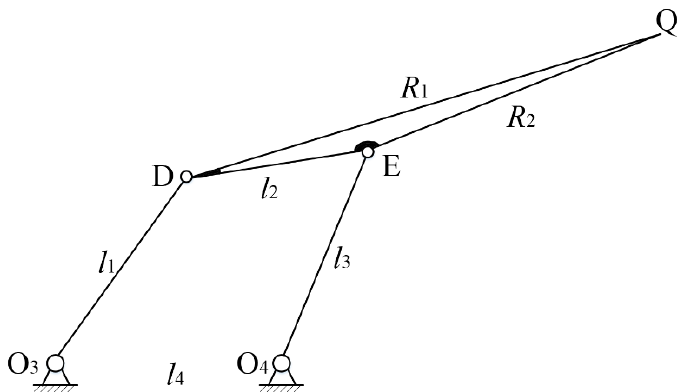
Figure 21. Diagram of four-bar linkage.